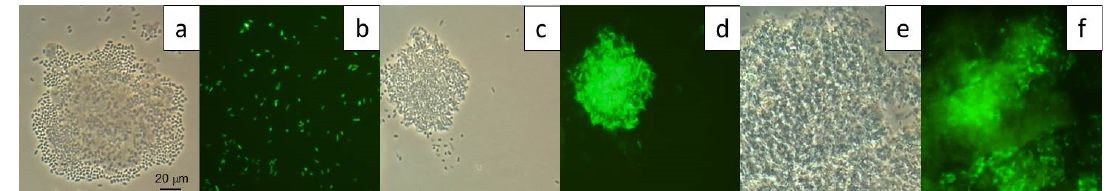
Figure 11. Microscope images of the strain ICP1-GM ( a ), ICTN13-GFP ( b ), and mixed cultures of the strains ICP1-GM and ICTN13-GFP ( c – f ) taken after 4 h ( c , d ) or 8 h ( a , b , e , f ) of growth on a minimal medium supplemented with 1.3 mM phenol. Images were made with a phase contrast ( a , c , e ) or with a fluorescence ( b , d , f ) microscope; image pairs—c, d and e, f—were made from the same field. Scale bar, 20 μ m.